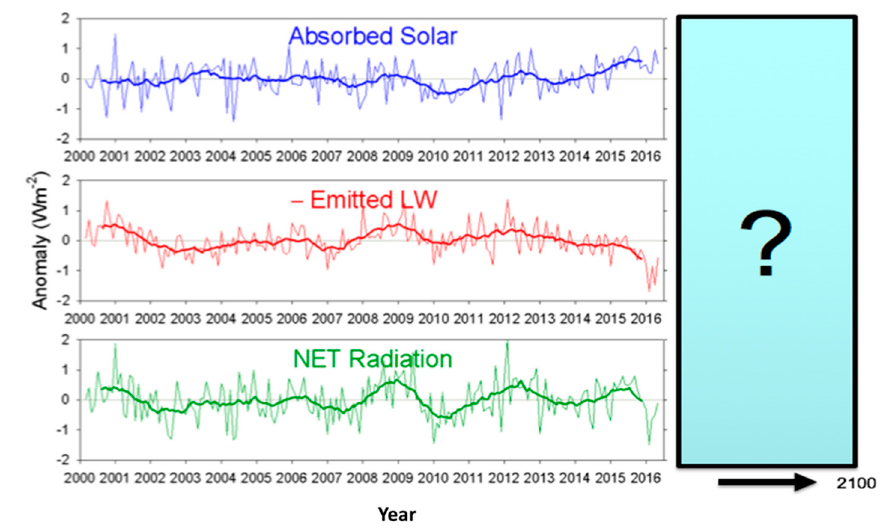
Figure 1. The 16-year top-of-the-atmosphere (TOA) Earth’s radiation budget (ERB) record from Clouds and Earth’s Radiant Energy System (CERES) for absorbed solar (blue), emitted longwave (red), and net radiation (green). The “?” represents the ~80 years of ERB data needed to extend the ERB record through the 21 st century, and holds the secrets to the climate sensitivity of Earth, the magnitude of cloud feedback, the magnitude and controls on internal multi-decadal variability, and the radiative forcing of the climate. Plots courtesy of Norman Loeb.